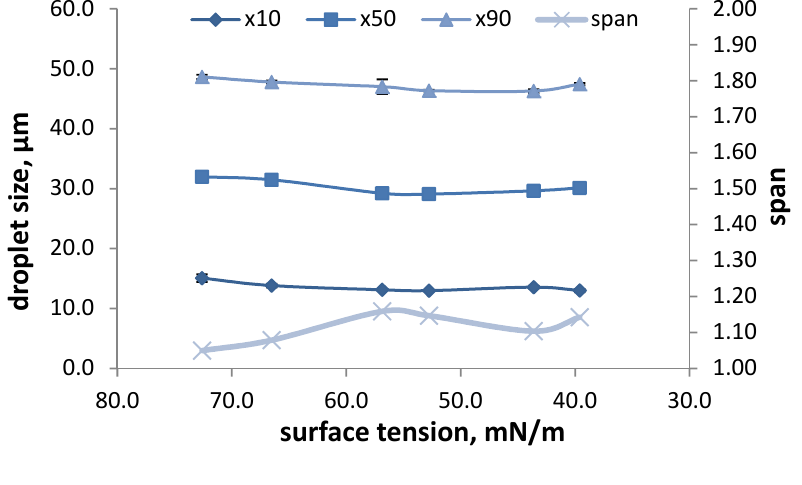
Figure 1. The effect of surface tension on the droplet size distribution (DSD) and span measured at 7 cm from the nozzle and an actuation force of 60 N. Results are presented as the average ± SD of three